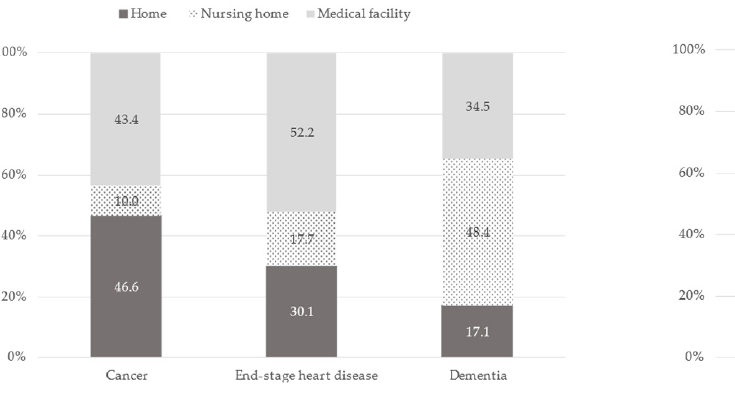
Figure 3. Proportion of preferred place of care by assumed clinical scenario stratified by age: ( a ) Age < 65 ( n = 492); ( b ) Age ≥ 65 ( n = 397). Likelihood-ratio test: p < 0.001, Wald test: p < 0.001.